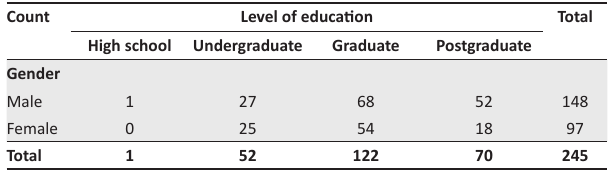
TABLE 1: Gender level of education cross-tabulation.